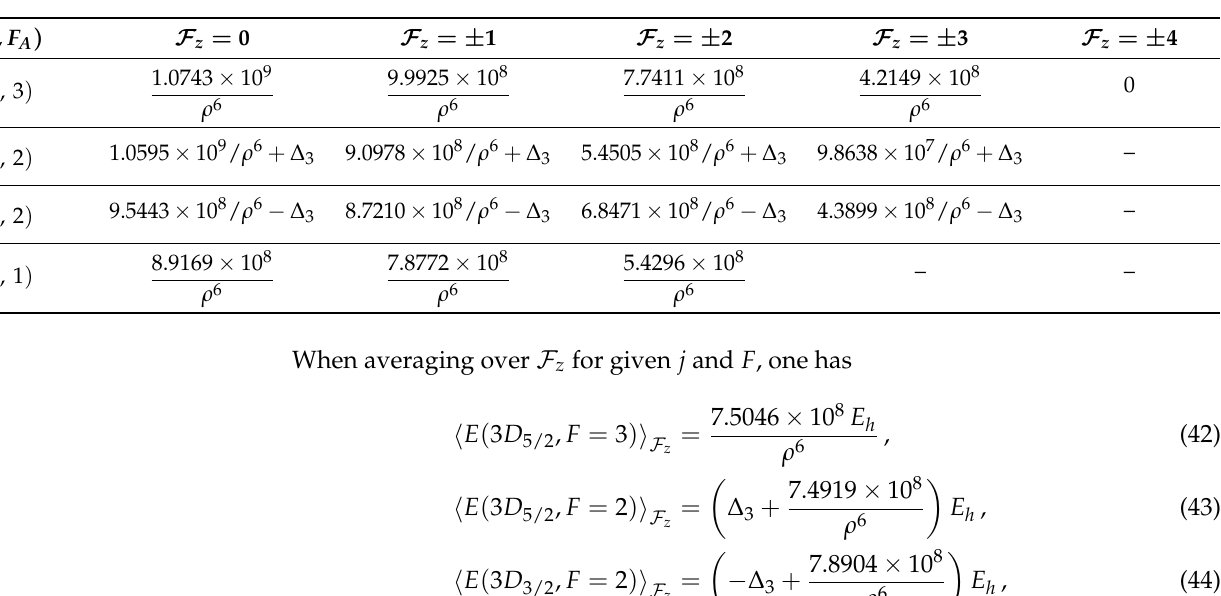
Table 2. Second-order van-der-Waals shifts of the 1/ R 6 -type are given for 3 D j hydrogen atoms interacting with 2 S -state hydrogen via virtual P states. Entries marked with a long hyphen (–) indicate unphysical combinations of F and F z values, within our basis of states. We denote the scaled interatomic distance by ρ = R / a 0 and give all energy shifts in atomic units, i.e., in units of the Hartree energy E h = α 2 m e c 2 . The symbol ∆ 3 denotes the fine-structure-hyperfine-structure mixing term, which is given in Equation (33). Recall that F z = F z , A + F z , B ; however, the F A quantum number in the table is that of the 3 D j state, which constitutes the reference